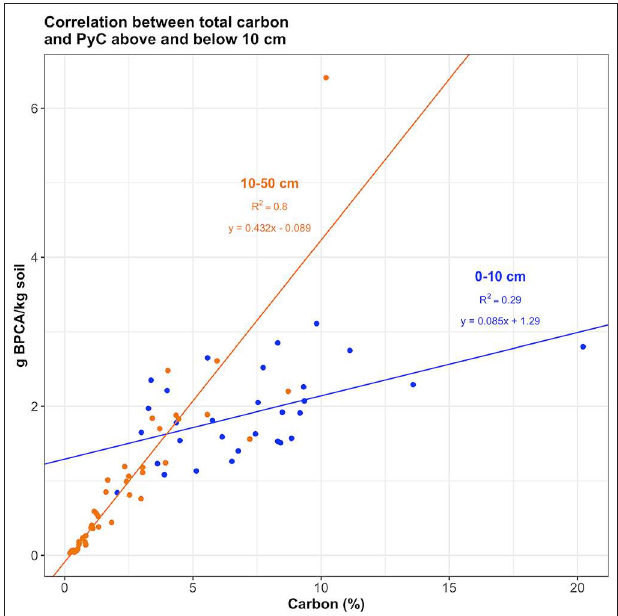
FIGURE 7 | There was a strong correlation ( R 2 = 0.80) between carbon concentration and PyC concentration at depths below 10cm (orange); however, this correlation is much weaker ( R 2 = 0.29) in the top 10cm